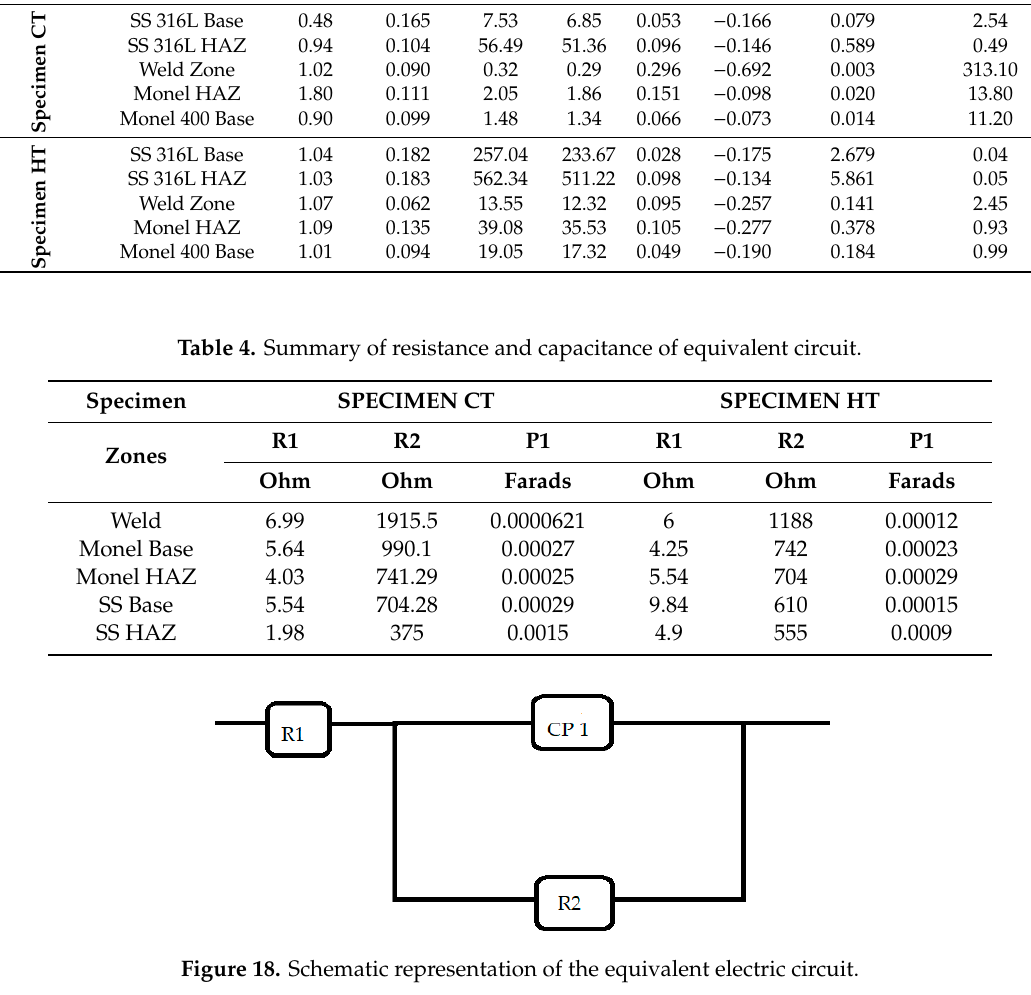
Figure 18. Schematic representation of the equivalent electric circuit. Table 4. Summary of resistance and capacitance of equivalent circuit.